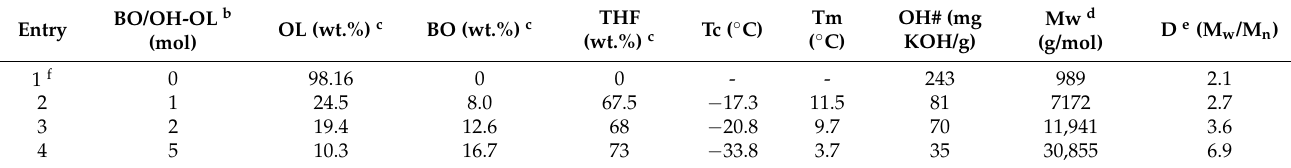
Scheme 2. Proposed CROP polymerization with butylene oxide as oxirane in THF in the presence of lignin adapted from our previous work [17]. Table 1. Influence of the BO amount on the LBP microstructure a